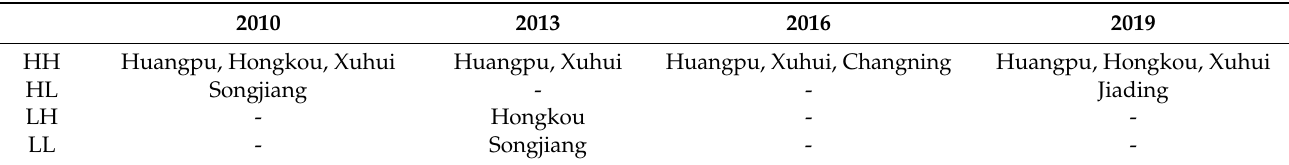
Table 6. Moran scatterplot urban distribution in